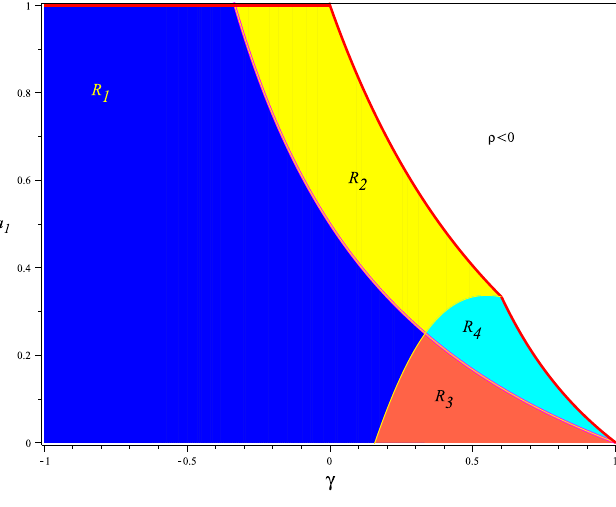
Figure 3. Bianchi II model (BII) with an effective stress-energy tensor defined by: eff T µν = T µν + ( φ ) T ( V ) T µν + µν . Plot of the region R where the energy density is positive ρ 0 > 0 and K area), with γ ∈ ( − 1,1 ] and a 1 ∈ ( 0,1 ] . See (97) for an